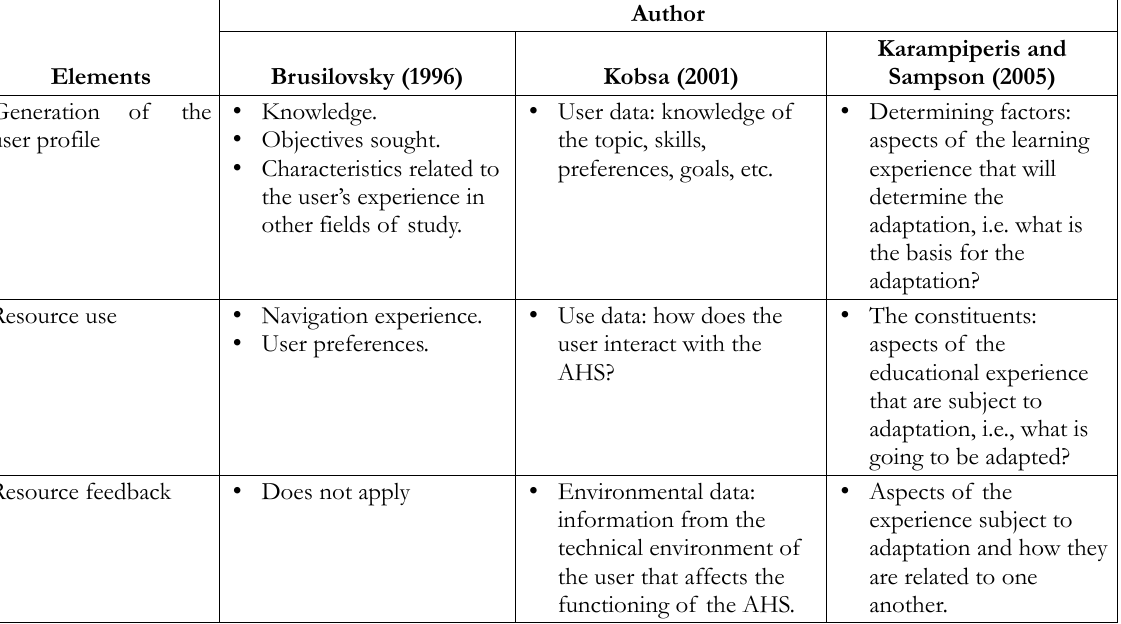
Table 5. Elements considered for the